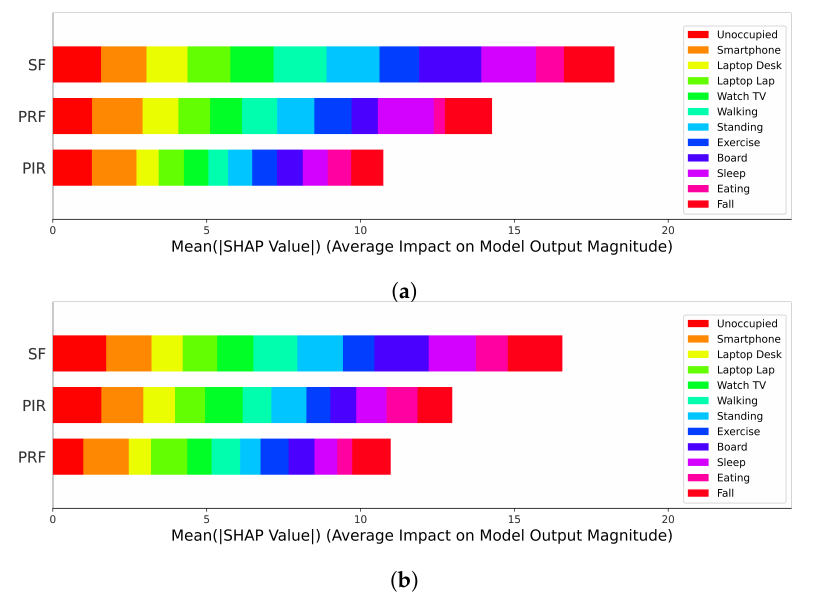
Figure 7. Summary plot of PRF, PIR, and PRF-PIR sensor fusion Shapley values when the antenna is in ( a ) C location and ( b ) E